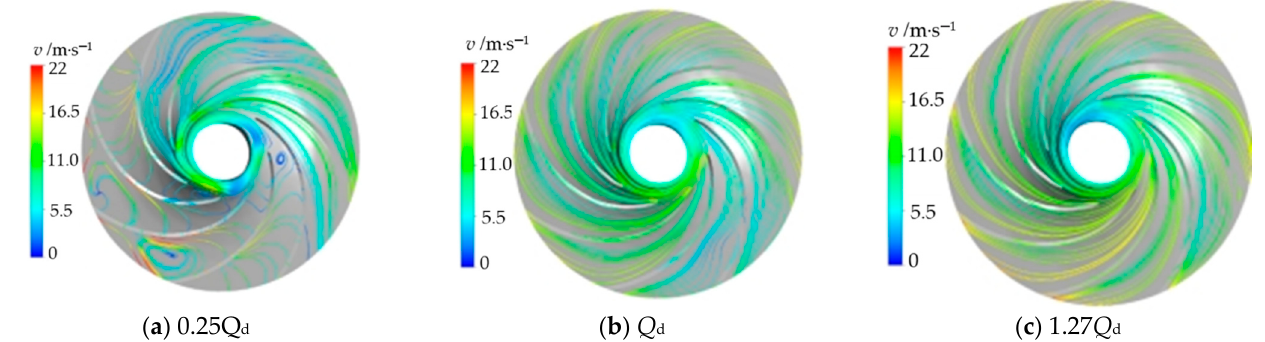
Figure 8. Flow pattern in the impeller under different flow rate conditions (15 kg/m 3 ).